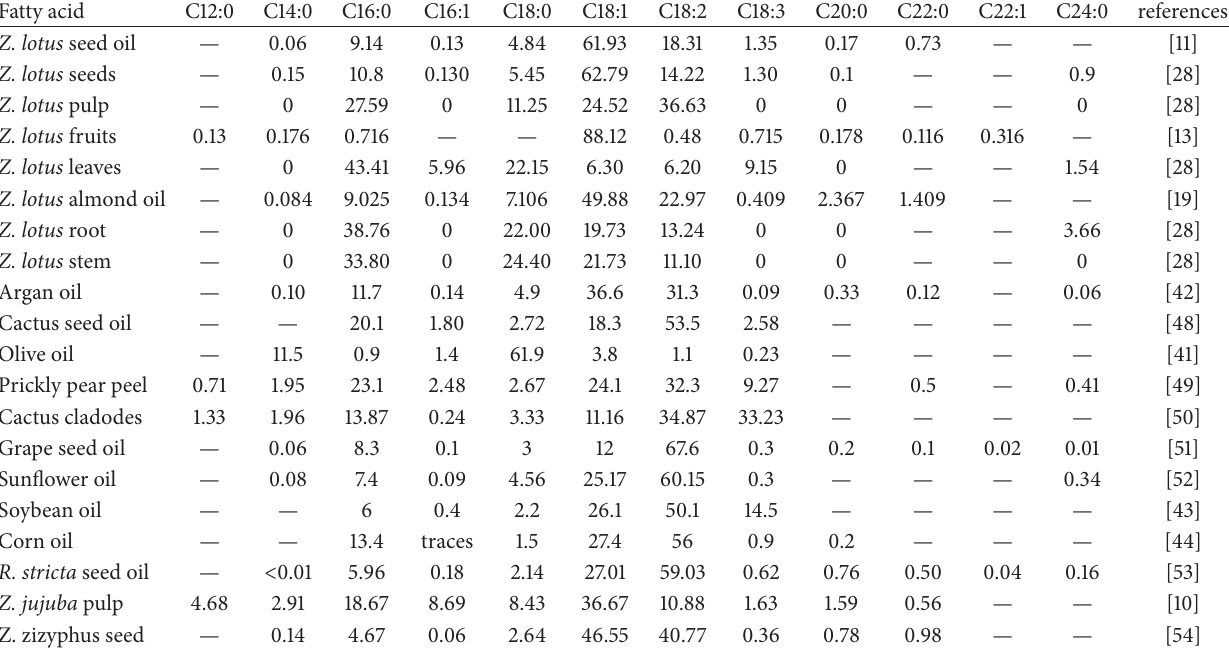
Table 2: Comparison of the fatty acid composition of Z. lotus and other edible oils; compositions are expressed in g/100g fatty acids.